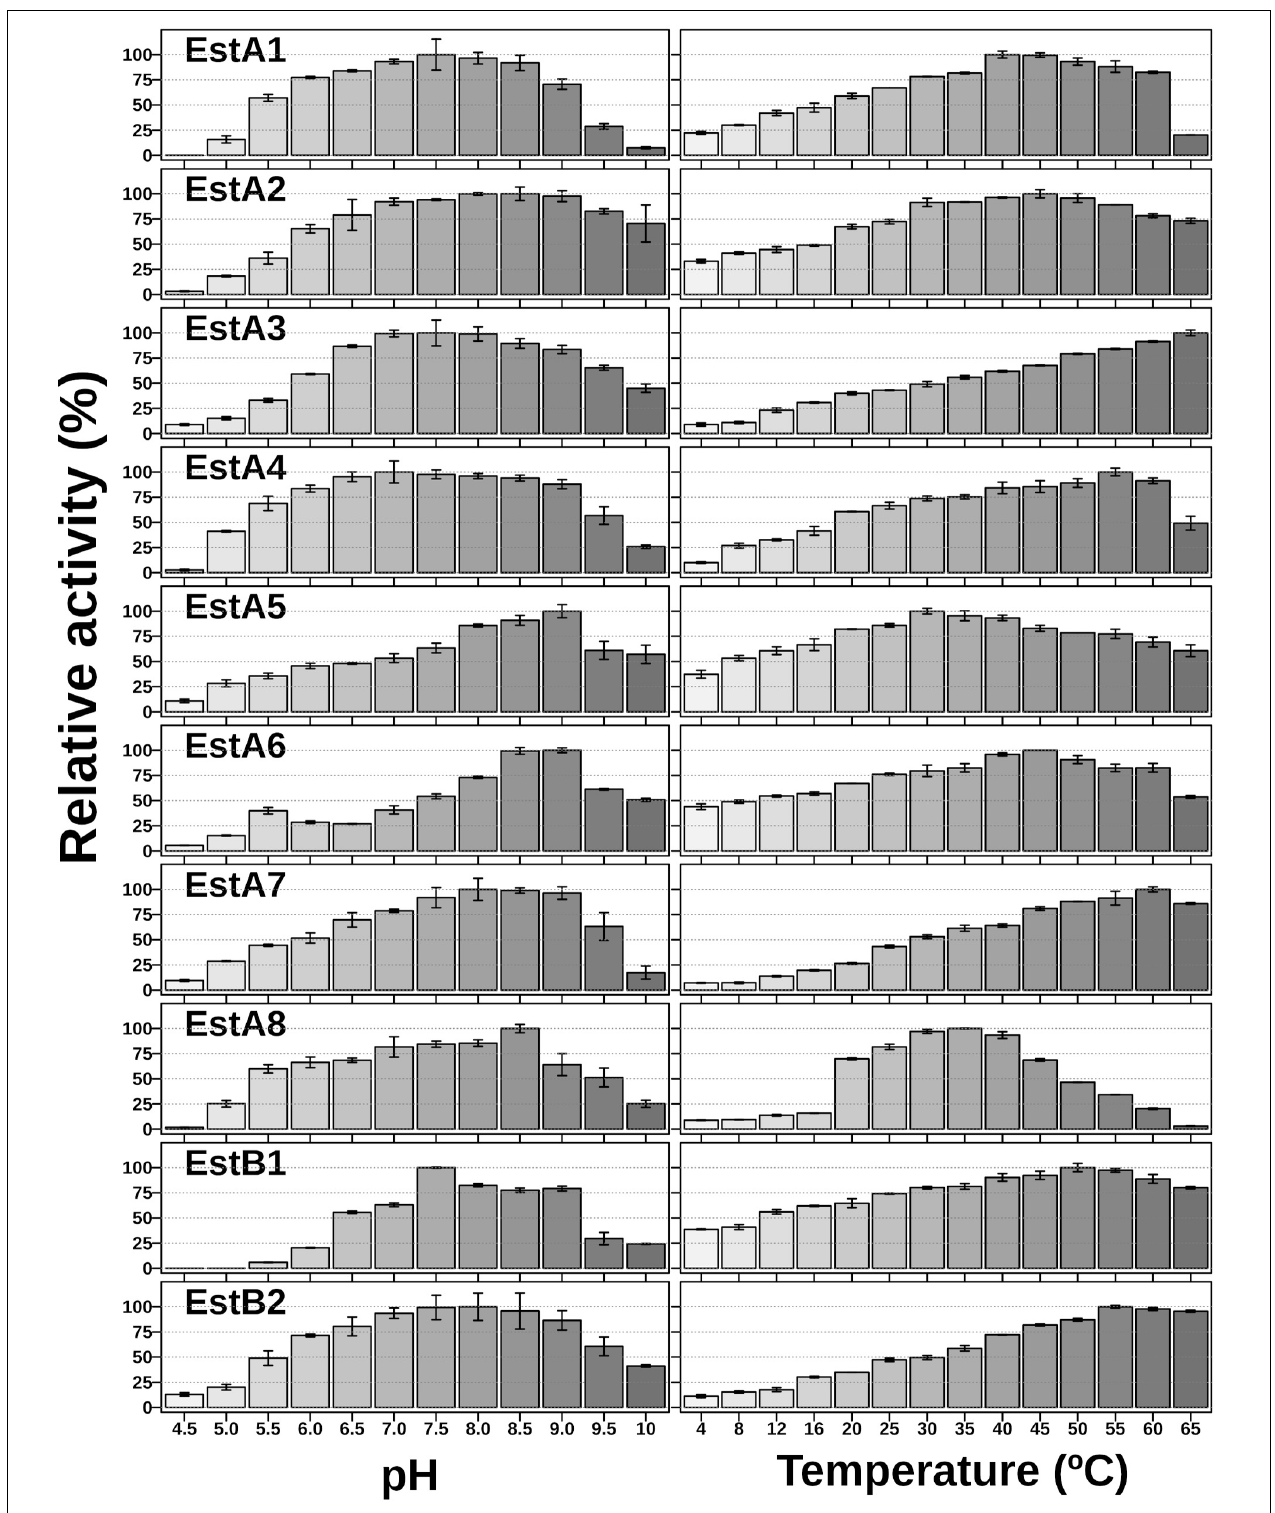
FIGURE 2 | pH and thermal profiles of the purified enzymes. The data represent the relative percentages (%) of specific activity (U/g) in triplicates compared with the maximum activity using p NPC 3 as substrate. For raw data see Supplementary Table 1 .